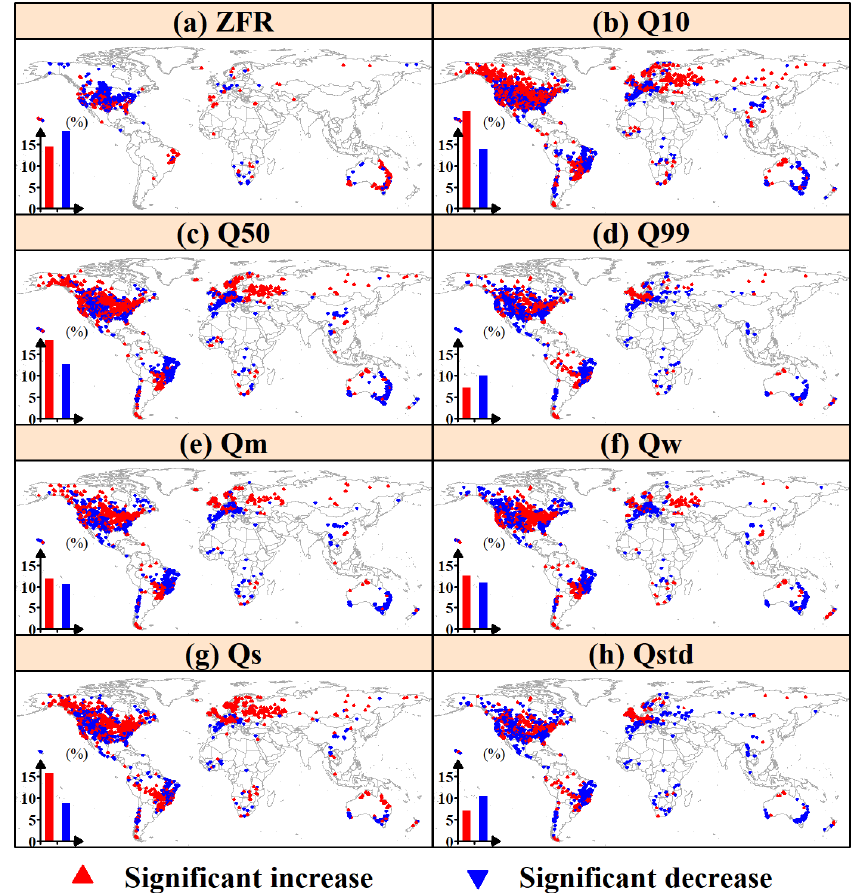
Figure 2. Spatial patterns of trends in eight runoff signatures based on the Mann-Kendall test at the 0.05 significance level (1975–2017). The red (blue) triangle represents a significant increase (decrease). The bar chart shows the percentages of stations with significant trends.